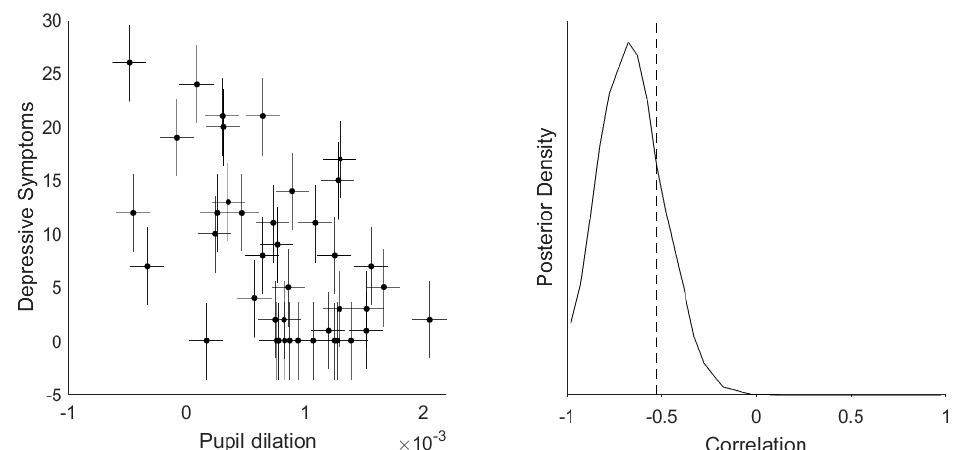
Figure 3. Correlation between pupil dilation and number of current symptoms with measurement uncertainty in depressed participants. Estimation of the correlation between the number of current depressive symptoms and pupil dilation to the reward stimulus with horizontal and vertical error bars representing the measurement uncertainty of the respective readouts ( left panel ). These measurement errors were incorporated into a Bayesian model that estimated the true correlations from observations sampled from a multivariate Gaussian distribution. The posterior distribution ( right panel ) provided very strong evidence that the true correlation is more negative than − 0.3 (the dashed line represents the actual Pearson correlation value); the BF 10 for r < − 0.3 = 42.2).